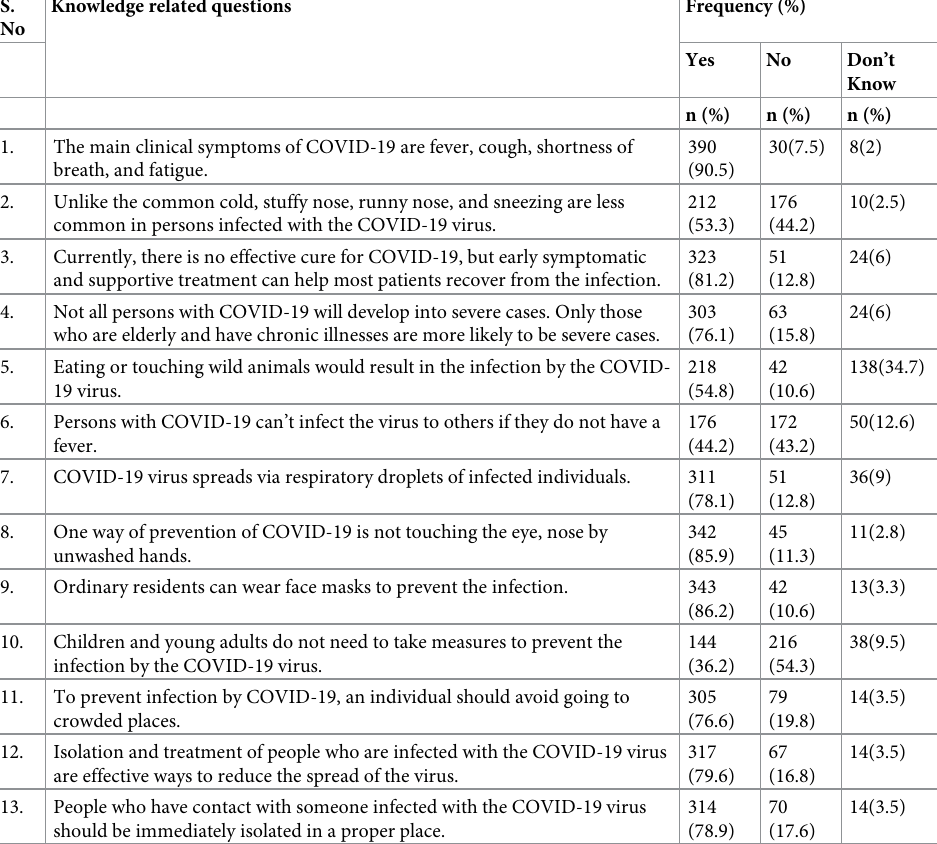
Table 2. Knowledge towards COVID-19 among outpatient service visitors at Debre Markos comprehensive spe- cialized hospital, Amhara regional state, Ethiopia, 2020. S.